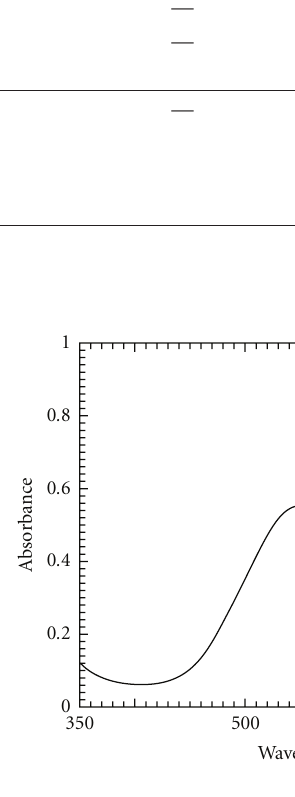
Figure 1: Absorbance spectrum of the colored product produced from the reaction of AHTT and 30 µ g mL − 1